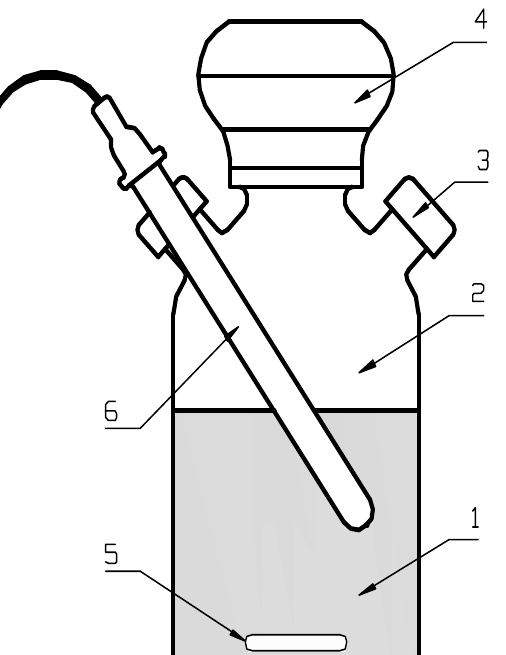
Figure 1. Single respirometric measuring kit, 1—measuring tank liquid phase, 2—measuring tank gaseous phase, 3—side port for biogas collection, 4—measuring and registering device, 5—magnetic stirrer, and 6—pH electrode.